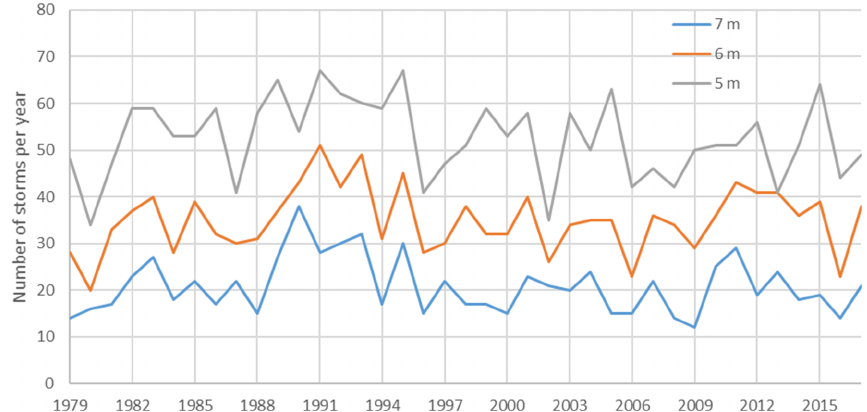
Figure 6. The number of storms with a significant wave height of more than 5, 6 and 7m according to the WWIII simulation results for the 1979–2017 period.